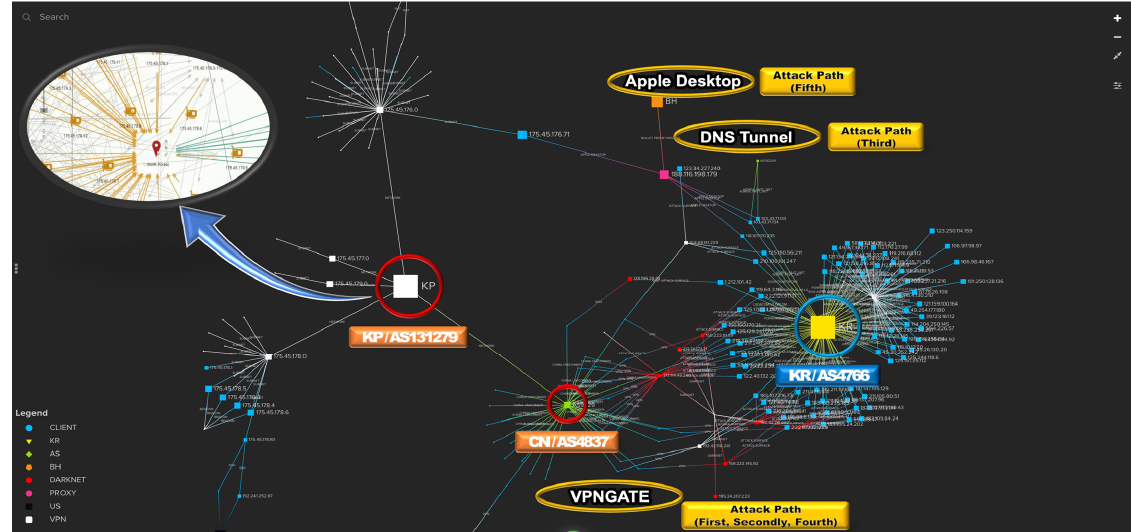
Figure 11. Visualization of North Korean cyber ISR based on BGP archive data.